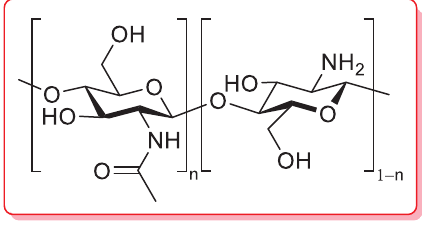
Figure 5. Chemical structure of chitosan.